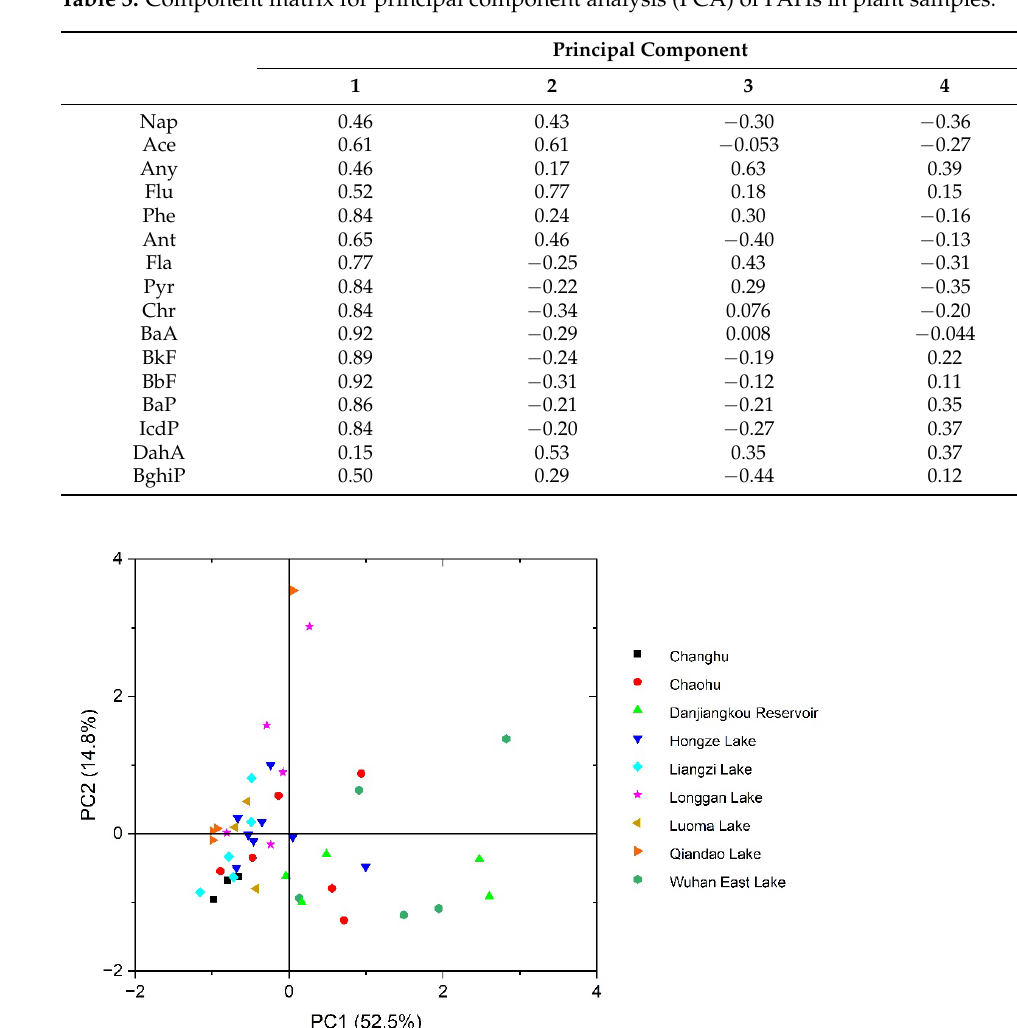
Table 3. Component matrix for principal component analysis (PCA) of PAHs in plant samples.